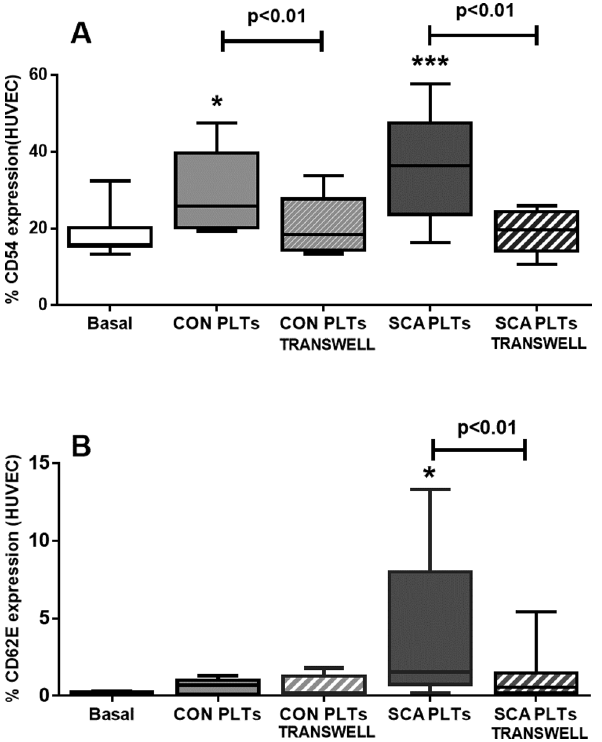
Figure 4. Transwell inserts reverse the effects of SCA platelets on endothelial adhesion molecules expression. Surface expres- sions of (A) ICAM-1 (CD54) and (B) E-selectin (CD62E) adhesion molecules on HUVEC (1 6 10 6 cells/well) following culture in the presence of healthy control (CON; N $ 6; 1 6 10 8 PLTs/well) PLTs or steady-state sickle cell anemia (SCA; N $ 12; 1 6 10 8 PLTs/well) PLTs and in the presence and absence of transwell inserts (0.4 m m pores). Expressions of ICAM-1 and E-selectin were evaluated by flow cytometry using anti-CD54-PE and CD62E-APC. *, p , 0.01; ***, p , 0.001, compared to basal (N=9).